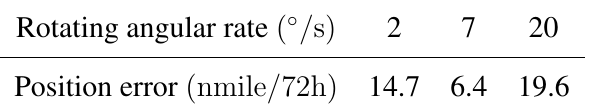
Table 11. Experimental